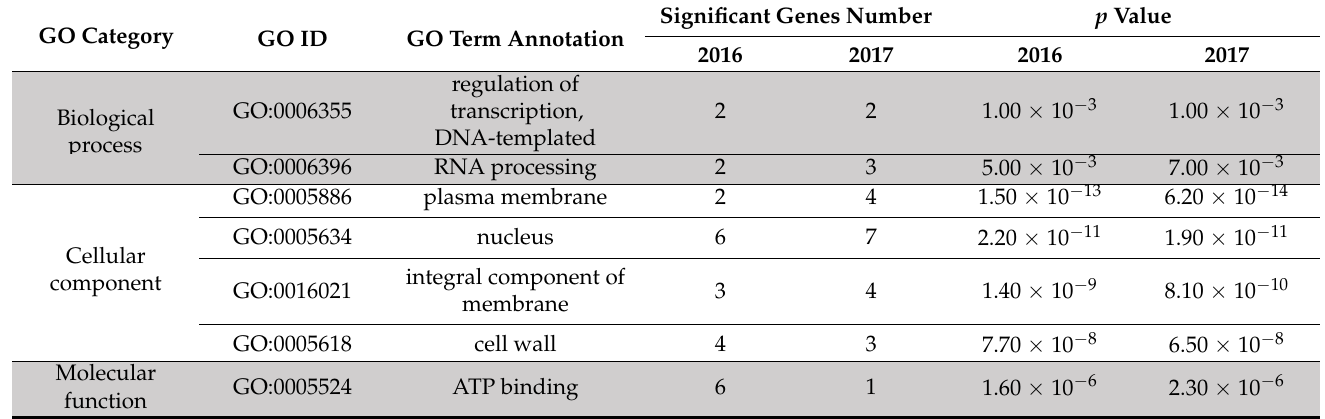
Table 4. GO terms of candidate genes through topGO both in 2016 and 2017 ( p < 0.05).